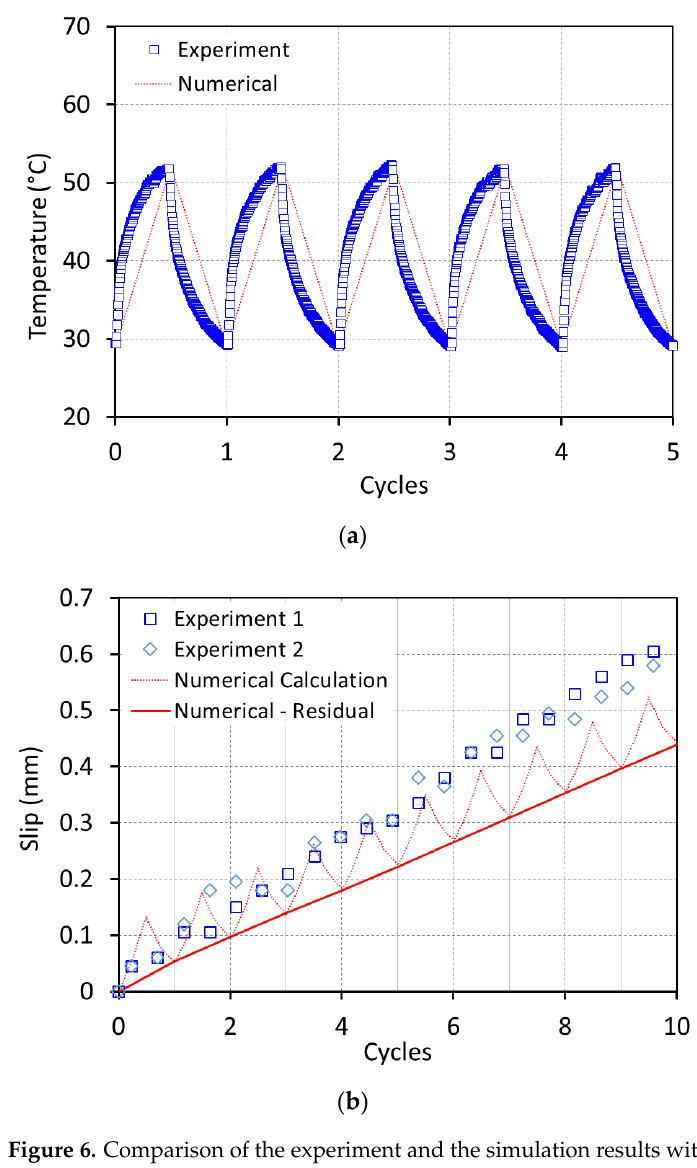
Figure 6. Comparison of the experiment and the simulation results with ∆𝑇 = 23 ℃ in 𝛽 = 5° slope. ( a ) Temperature cycles during the actual experiments and the numerical simulations, and ( b ) slip accumulation of the acryl vs. temperature cycles.